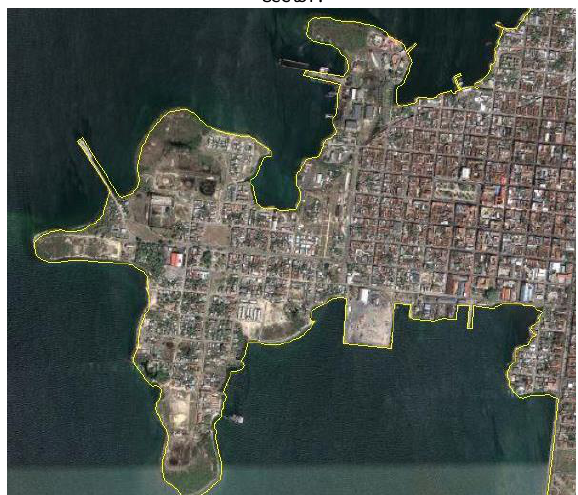
Figure 9. Result of the vector generated over an anthropized coast sector.